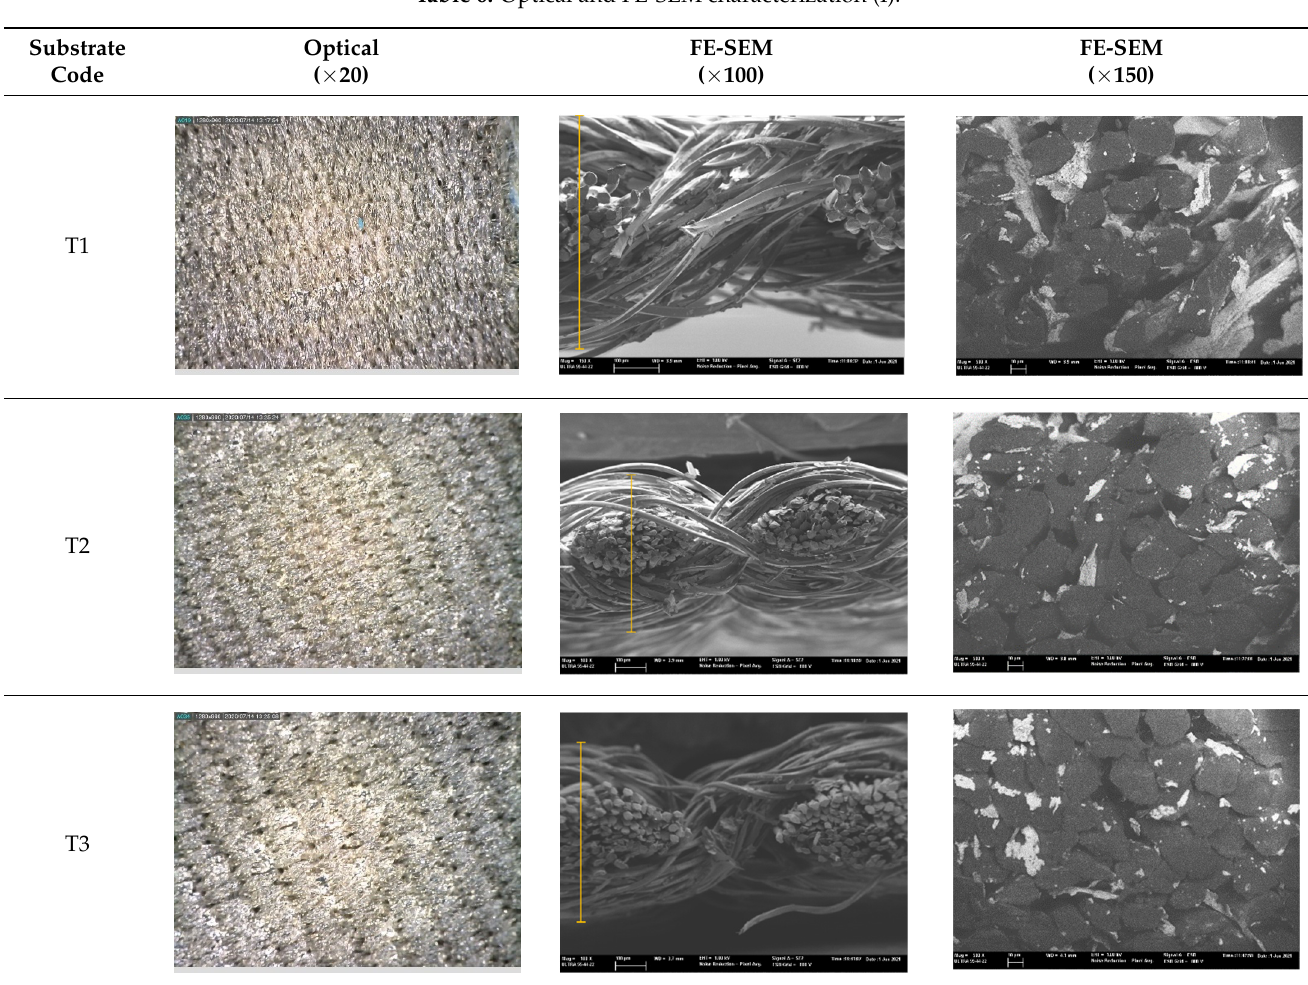
Table 6. Optical and FE-SEM characterization (I).